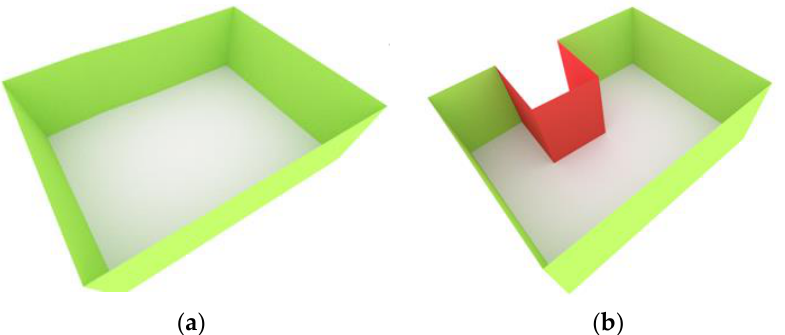
Figure 4. ( a ) A convex cell represented by its walls surfaces (green) and its floor surface (white). ( b ) A non-convex cell that includes several wall surfaces as obstacles (red).